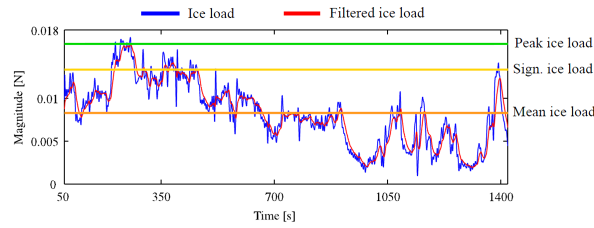
Figure 9: A simulated ice force series, with its aver- age, peak, and significant maximum indi- cated. Courtesy: Kjerstad et al. (2013) For each heading angle the vessel must then be sim- ulated multiple times in different stationary